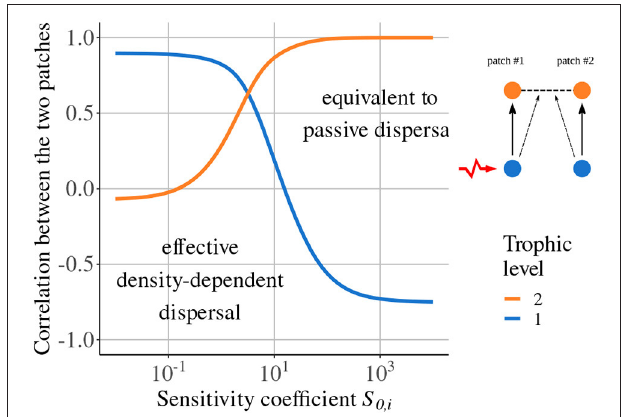
FIGURE 4 | Correlation between populations in the two patches depending on the sensitivity coefficient S 0, i . Prey in patch #1 receive stochastic perturbations and predator dispersal depends on prey biomass density. Prey do not disperse ( ε a 10, ma 10 and d 2 10 3 ). Adapted from Quévreux et al. (2021c). = = =